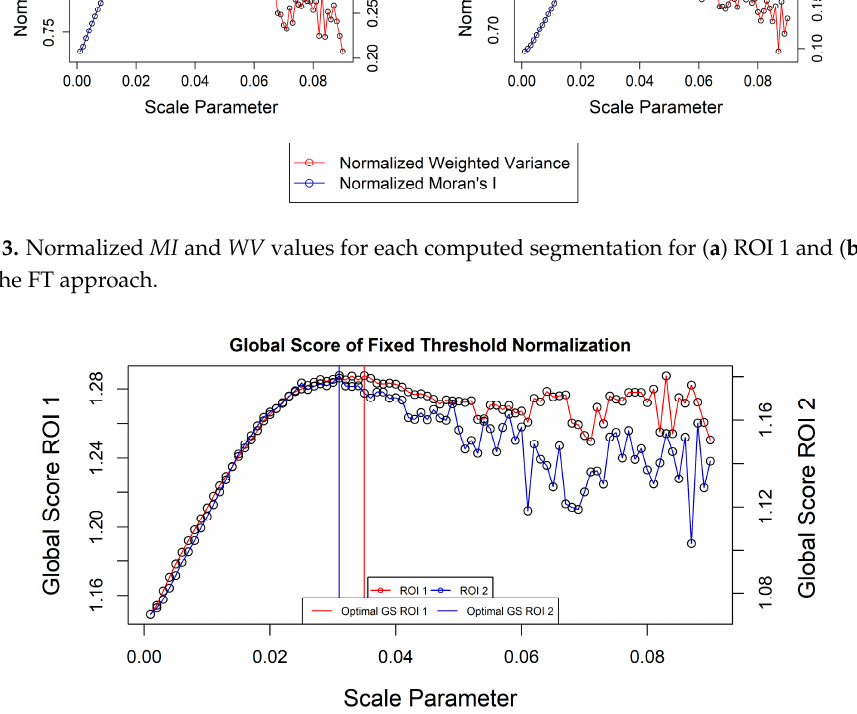
Figure 4. GS for each computed segmentation and ROI using the FT approach.